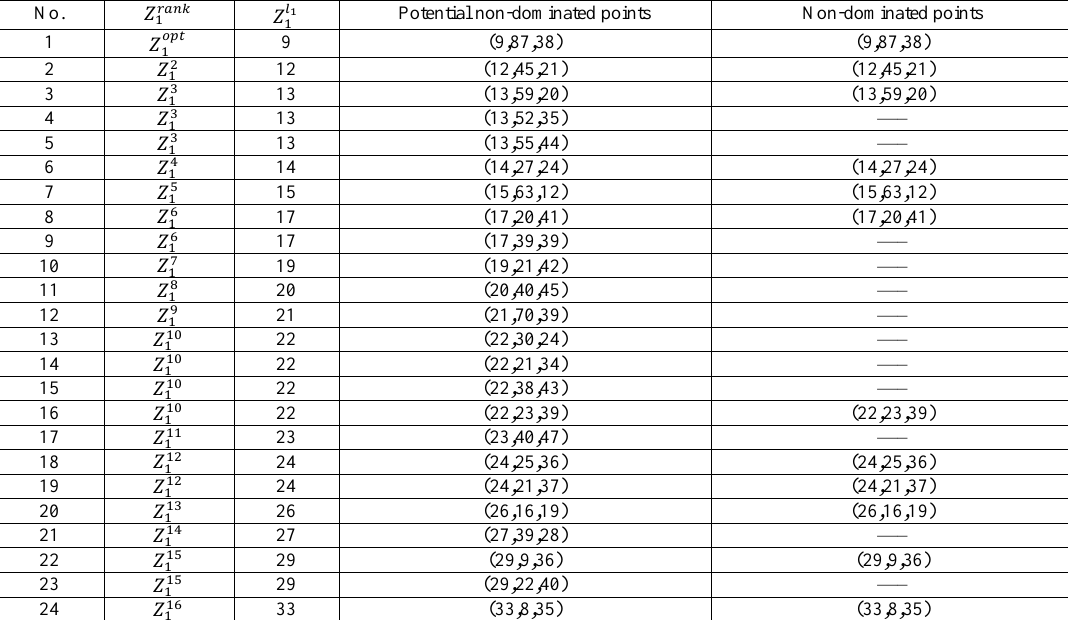
Table 8. Potential non-dominated points for first objective